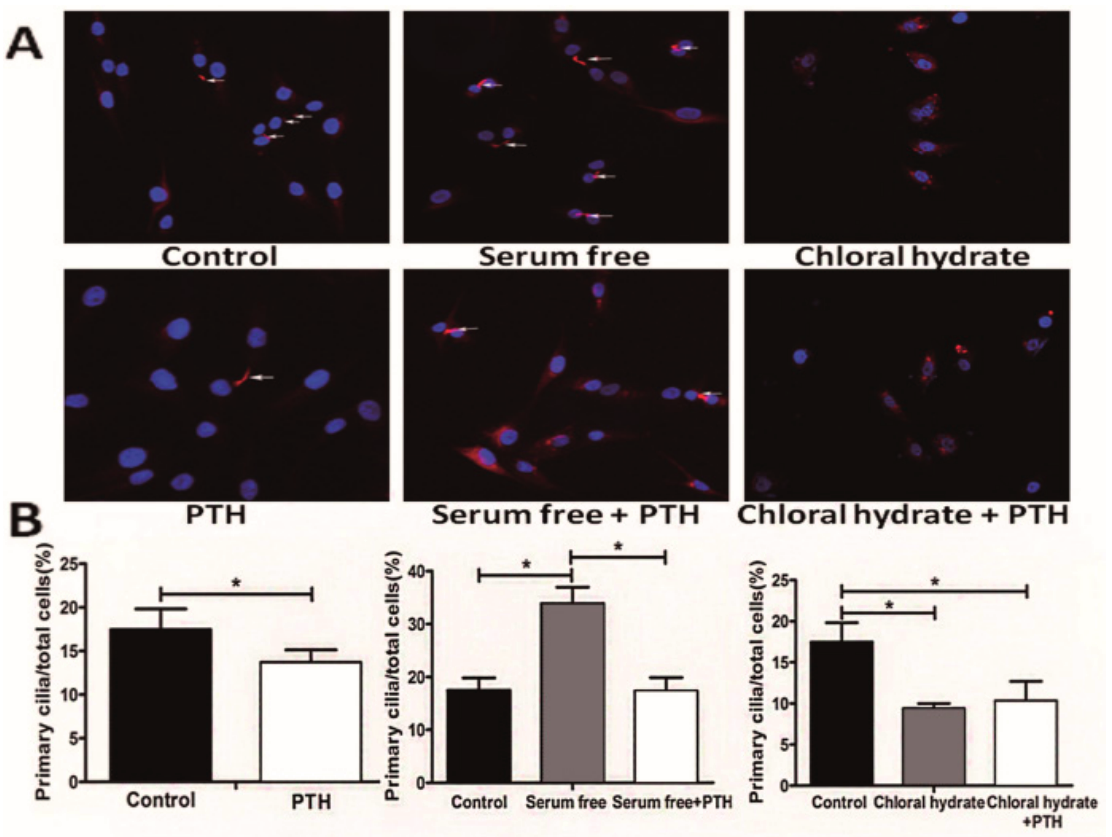
Figure 5. PTH could regulate SW1353 cells primary cilia assembly. These white arrows refer to primary cilia. Image A shows primary cilia expression on different condition and these histograms ( B ) display the percentage of primary cilia expression. ( * p < 0.05).